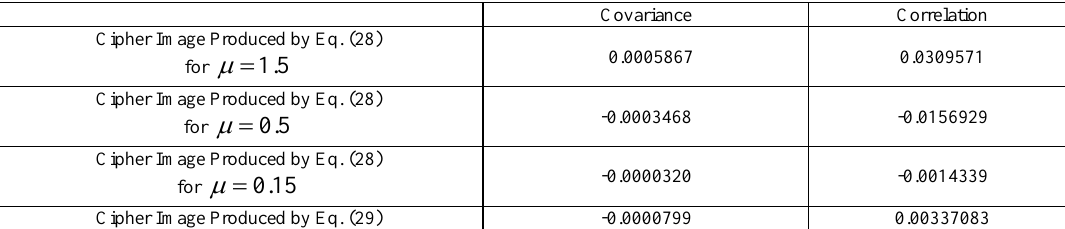
Table 1 . Covariances and correlations for the fractal image (Figure 1 on the left side) data based on the weighted data (gradient orientation filter, gradient filter) images. Covariance Correlation Cipher Image Produced by Eq. (28)